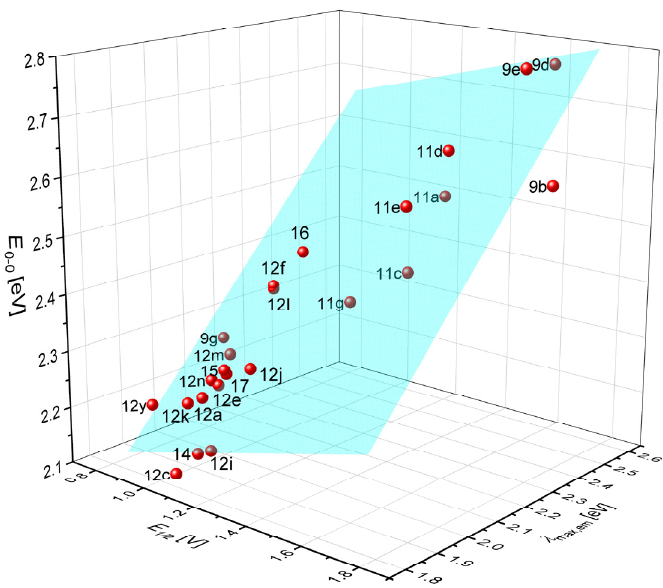
Figure 3. Correlation of the optical band gap E 0-0 vs. oxidation potential E 1/2 and emission maximum λ max,em : E 0-0 = 0.147· E 1/2 + 0.7019· λ max,em + 0.7296; r 2 =